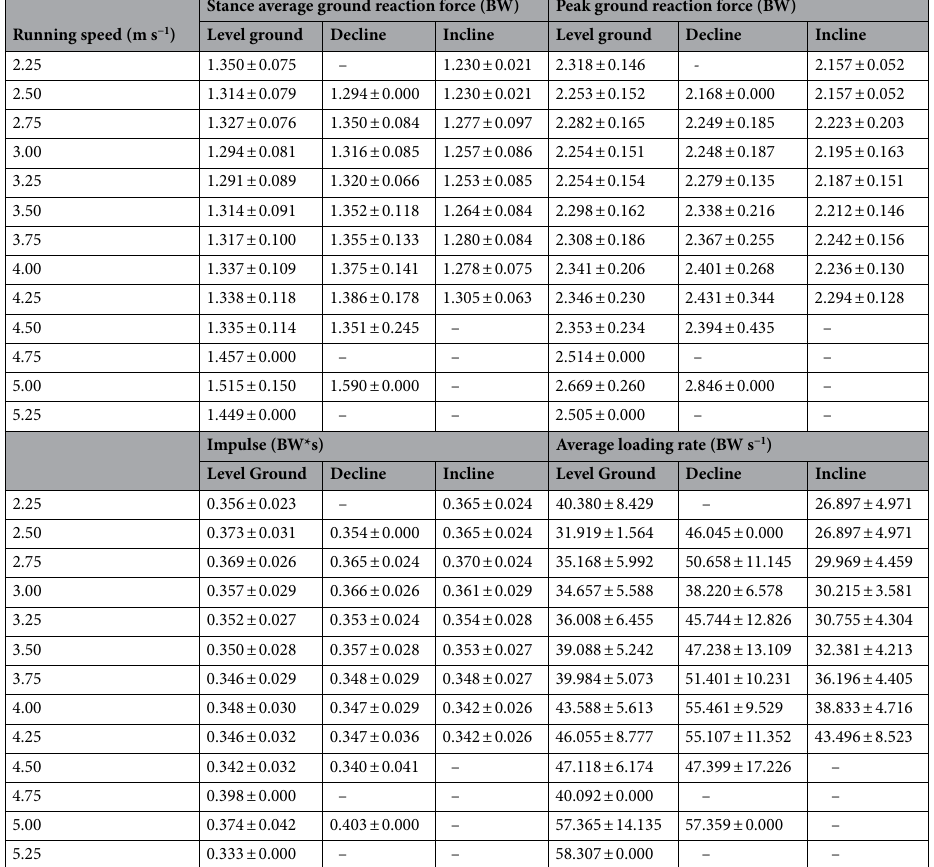
Table 5. Measured kinetic variables from force insoles (Mean ±